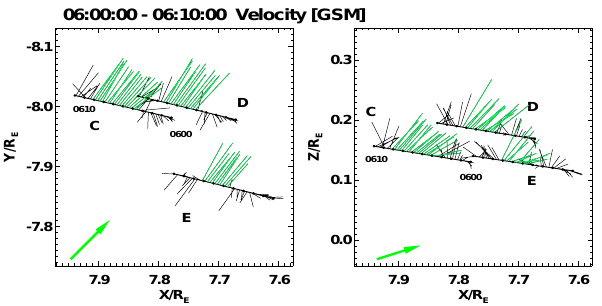
Fig. 6. Projections of ion velocities measured by THC, THD and THE onto the XY- and XZ-planes. The heavy green arrows at the bottom parts of both panels show the velocity directions in the mag- netosheath as measured by THB. The spacecraft moves from right to left in the order THC, THD and THE. The green colour indicates estimated magnetosheath